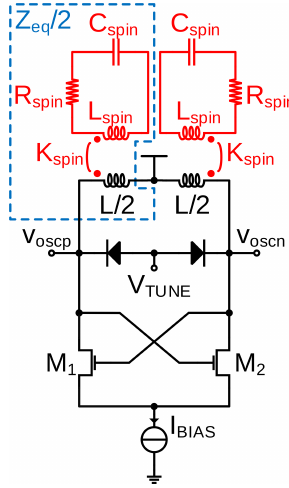
Figure 3. Model suitable to simulate VCO-based continuous-wave ESR experiments in a conventional circuit simulator. The effect of the spin ensemble on the oscillator is modeled by an inductive cou- pling between an RLC circuit (model for the spin ensemble) that couples inductively into the tank inductance of the oscillator circuit, cf. circuitry inside the dashed blue line in the